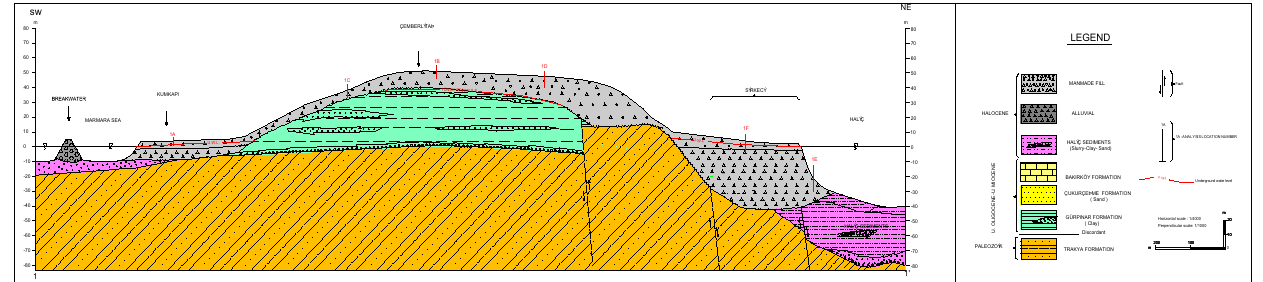
Figure 3. The location of the points on the 1-1 0 cross section where the 1-D and 2-D analyses were performed (Ince et al., 2008).